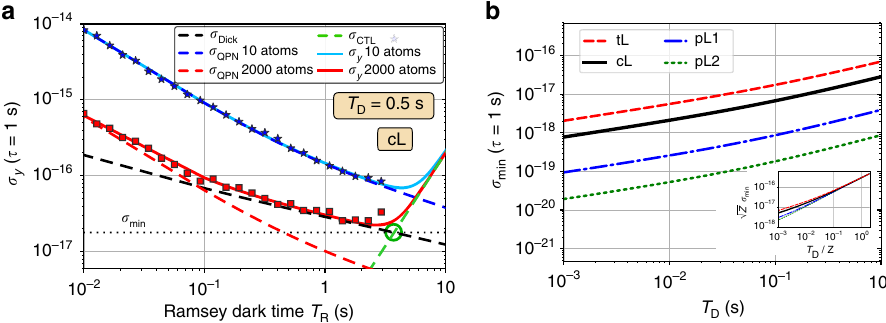
Fig. 2 Optimal clock stability. a Allan deviation σ y of an optical atomic clock at averaging time τ = 1 s as a function of Ramsey dark time T R assuming a dead time T D = 0.5 s and laser noise corresponding to the currently best ultra-stable clock lasers (cL) as characterized in Table 1. Solid lines are instabilities from the full noise model, Eq. (2), with N = 10 (blue) and N = 2000 (red) uncorrelated clock atoms. Dashed lines show the three contributing noise processes: QPN (blue and red), CTL (green), and the Dick noise (black). Symbols are numerical simulations of the closed feedback loop in agreement with the analytic model until the onset of fringe-hops leads to a sudden, strong increase in instability. b Bound on the minimal instability σ min as a function of dead time for four different types of clock lasers (tL, cL, pL1, pL2) as de fi ned in Table 1. Inset: Normalizing by the laser coherence time Z (as de fi ned in the main text and ffiffiffi p Z σ ¼ 3 : 0 ´ 10 (cid:2) 16 ð T = Z Þ 0 : 7 at longer dead times. We use the transition frequency ν given in Table 1) reveals an almost universal scaling with min D 429.228THz of 87 Sr for